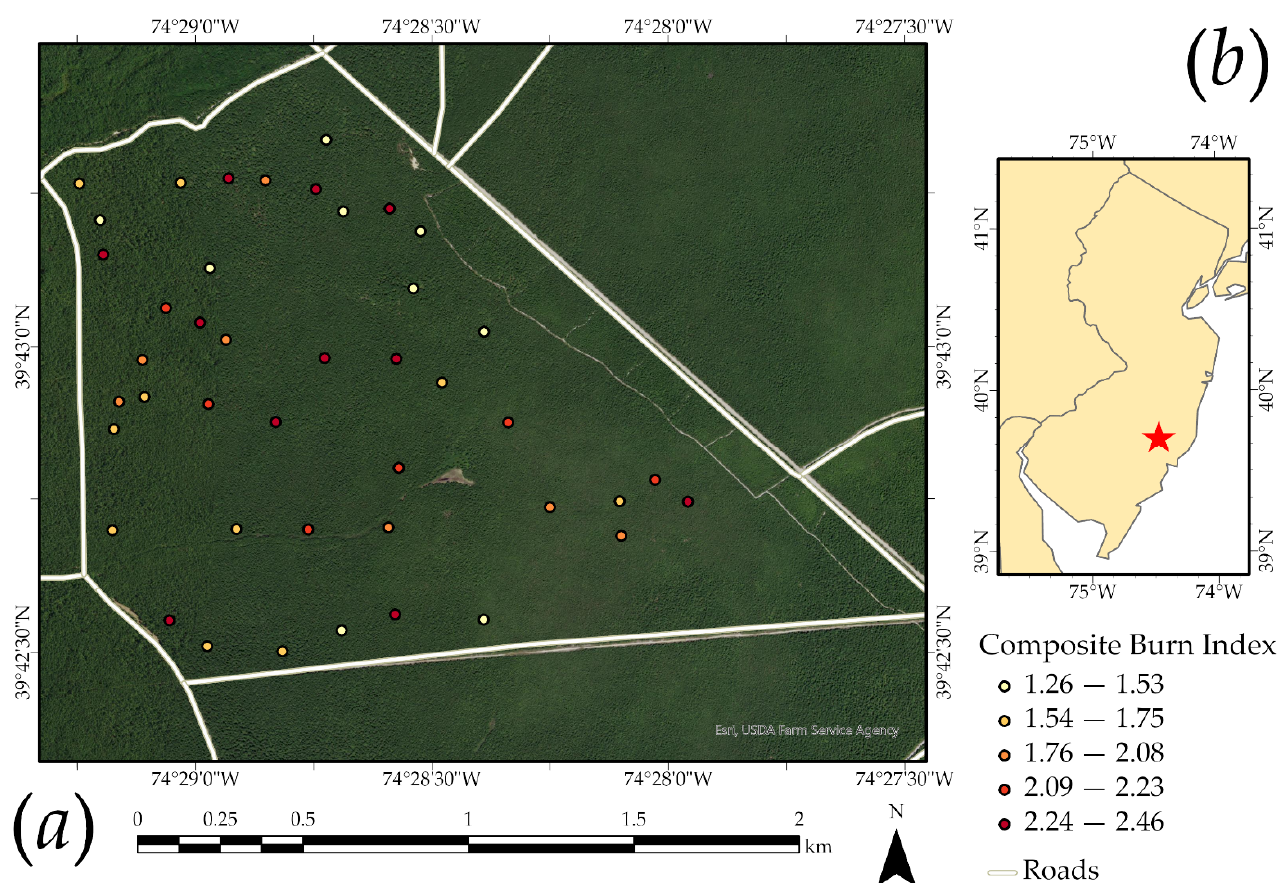
Figure 1. ( a ) Study area and field plots. ( b ) Location of study area in southern NJ, USA. Imagery from the National Agriculture Imagery Program (NAIP).